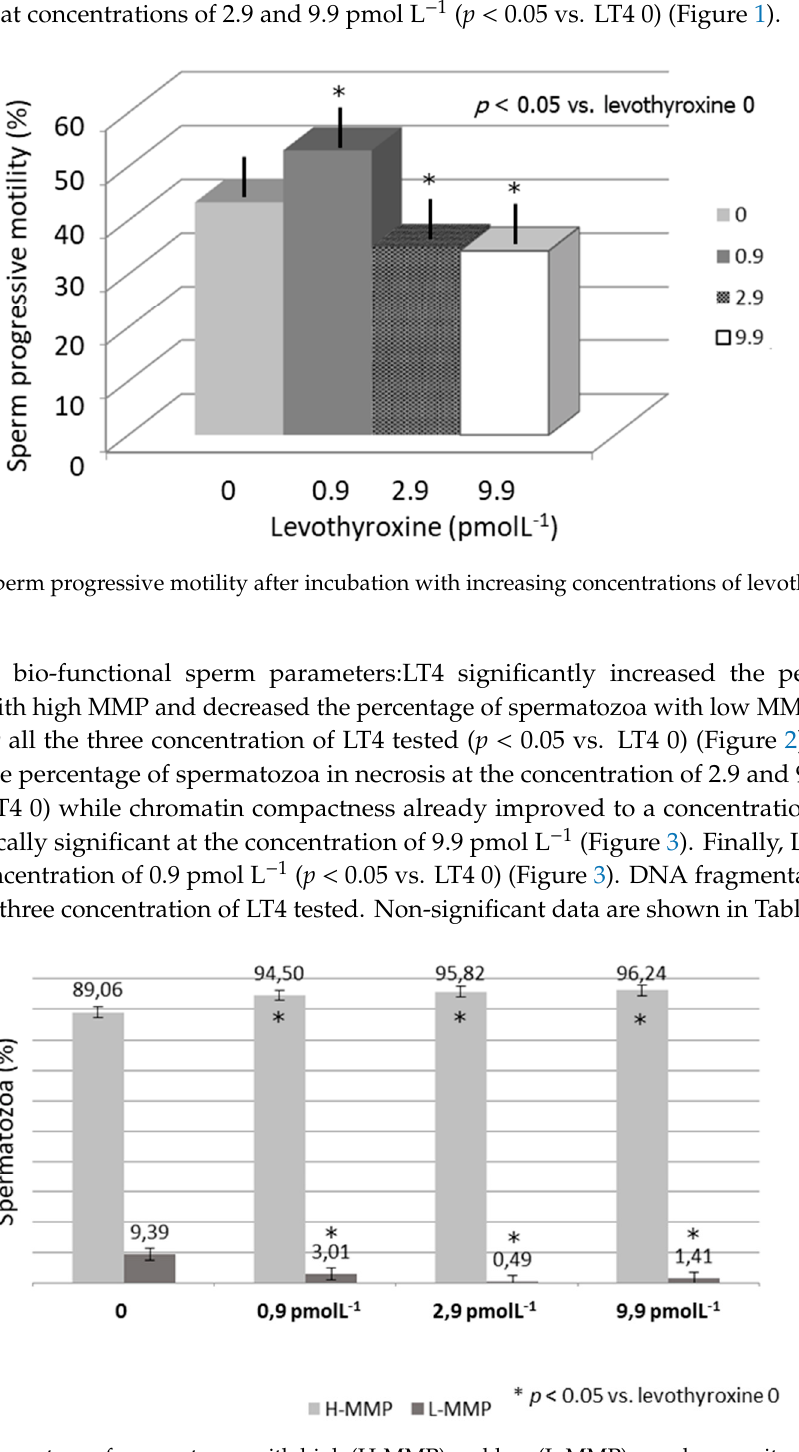
Figure 2. Percentage of spermatozoa with high (H-MMP) and low (L-MMP) membrane mitochondrial potential after incubation with increasing concentrations of levothyroxine (LT4).